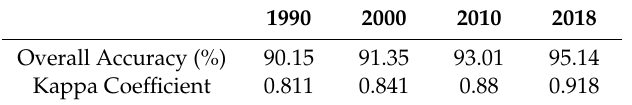
Table 3. Overall accuracy (%) of the LULC maps for the years 1990, 2000, 2010 and 2018.